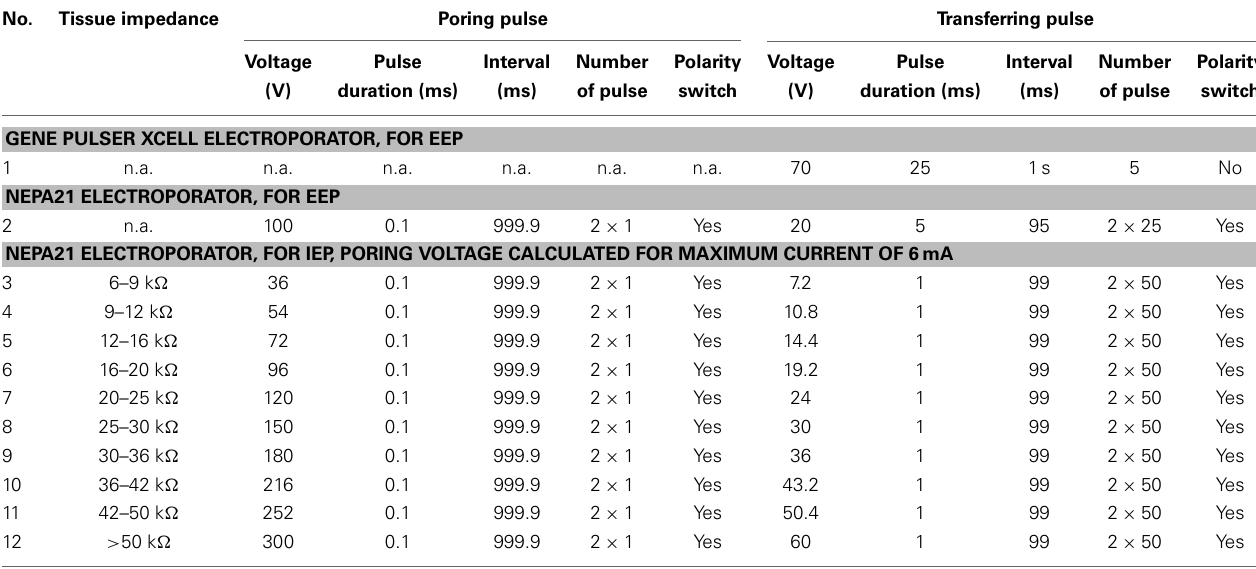
Table 3 | Pulse settings for electroporation. No. Tissue